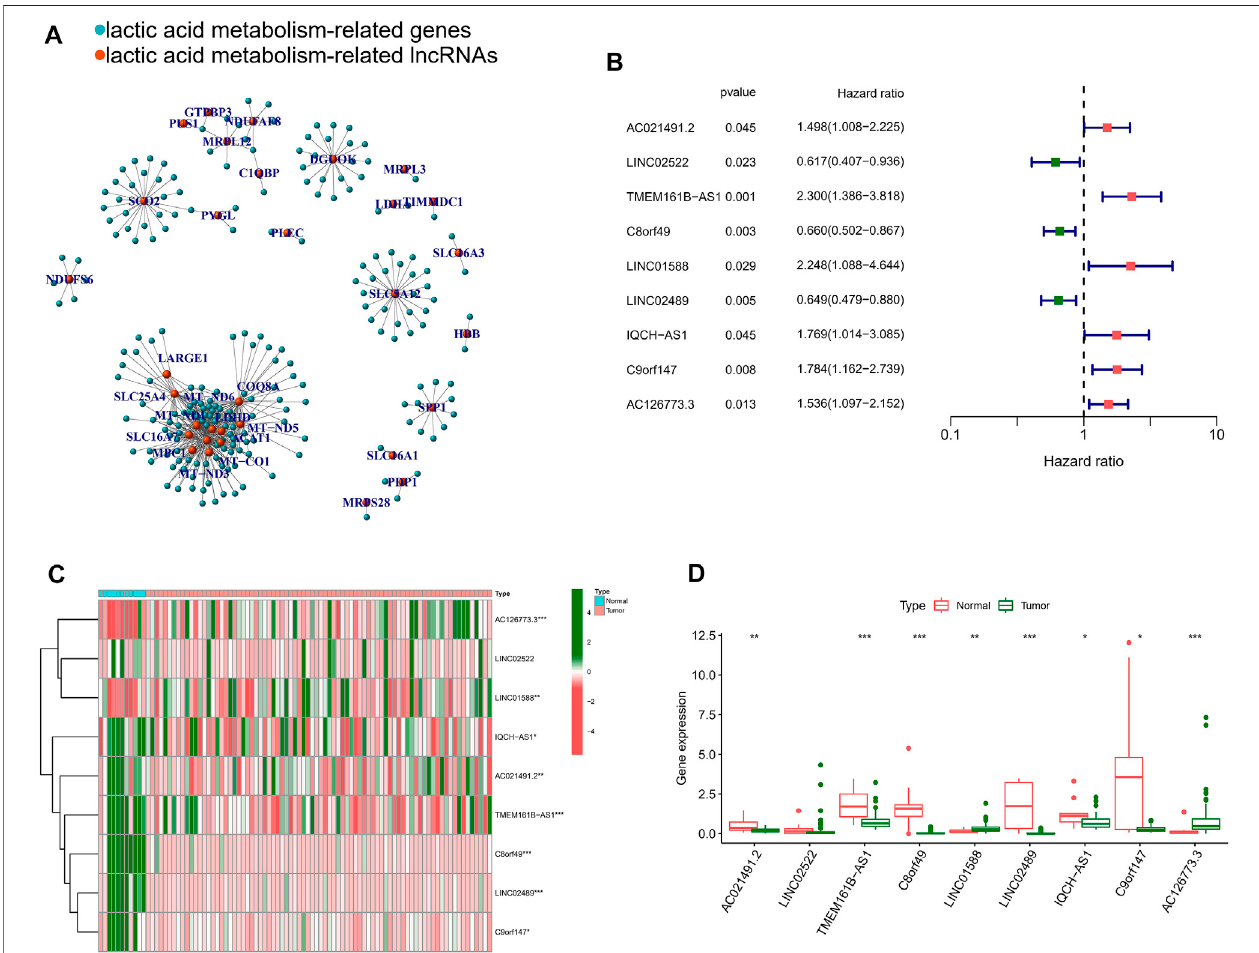
FIGURE2| Identi fi cationoflacticacidmetabolism-relatedprognosticlncRNAs. (A) Thenetworkofthe216lacticacidmetabolism-relatedlncRNAs. (B) Forrestplot of 9 lactic acid metabolism-related lncRNAs related with prognosis. (C) The heatmap of the 9 lactic acid metabolism-related lncRNAs. (D) Differential lncRNAs level between tumor tissues and normal tissues. * p < 0.05, ** p < 0.01, *** p < 0.001.